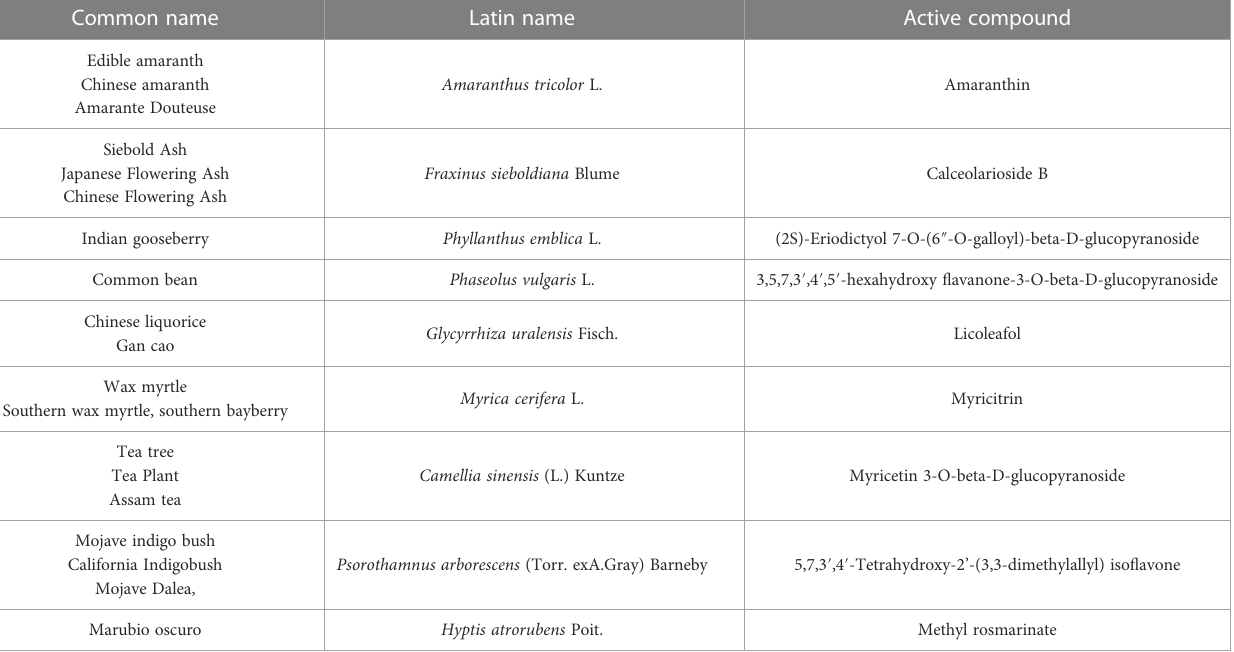
TABLE 2 Selected plant substances with potential antiviral